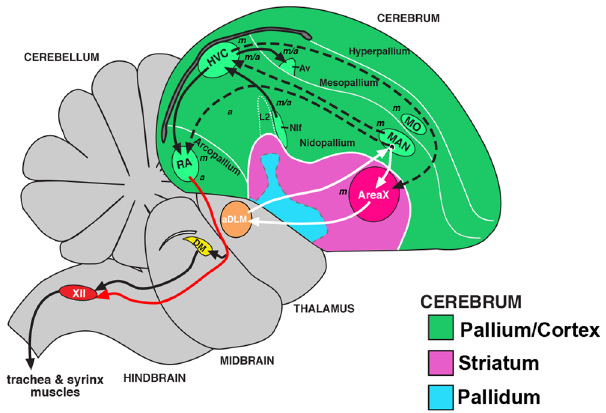
Figure 1. Schematic of brain pathways controlling song in songbirds. Figure modified from Chakraborty and Jarvis 23 . Black arrows, posterior vocal motor pathway; White arrows, anterior vocal learning pathway; Dashed arrows, connections between the two pathways; Red arrow, specialized direct projection from forebrain to brainstem vocal motor neurons in vocal learners. Italicized letters indicates that these regions mainly show motor (m) , auditory (a) , equally both motor and auditory (m/a) neural activity or activity-dependent gene expression in awake animals. Not all connections are shown, for simplicity. Abbreviations: Av, avalanche; aDLM, anterior dorso-lateral nucleus of the thalamus; DM, dorsal medial nucleus of the midbrain; H, hyperpallium; HVC, a vocal nucleus (no abbreviation); L2, field L2; M, mesopallium; MAN, magnocellular nucleus of the anterior nidopallium; MO, oval nucleus of the anterior mesopallium; N, nidopallium; Nif, interfacial nucleus of the nidopallium; RA, robust nucleus of the arcopallium; XII, 12 th nucleus, tracheosyringeal